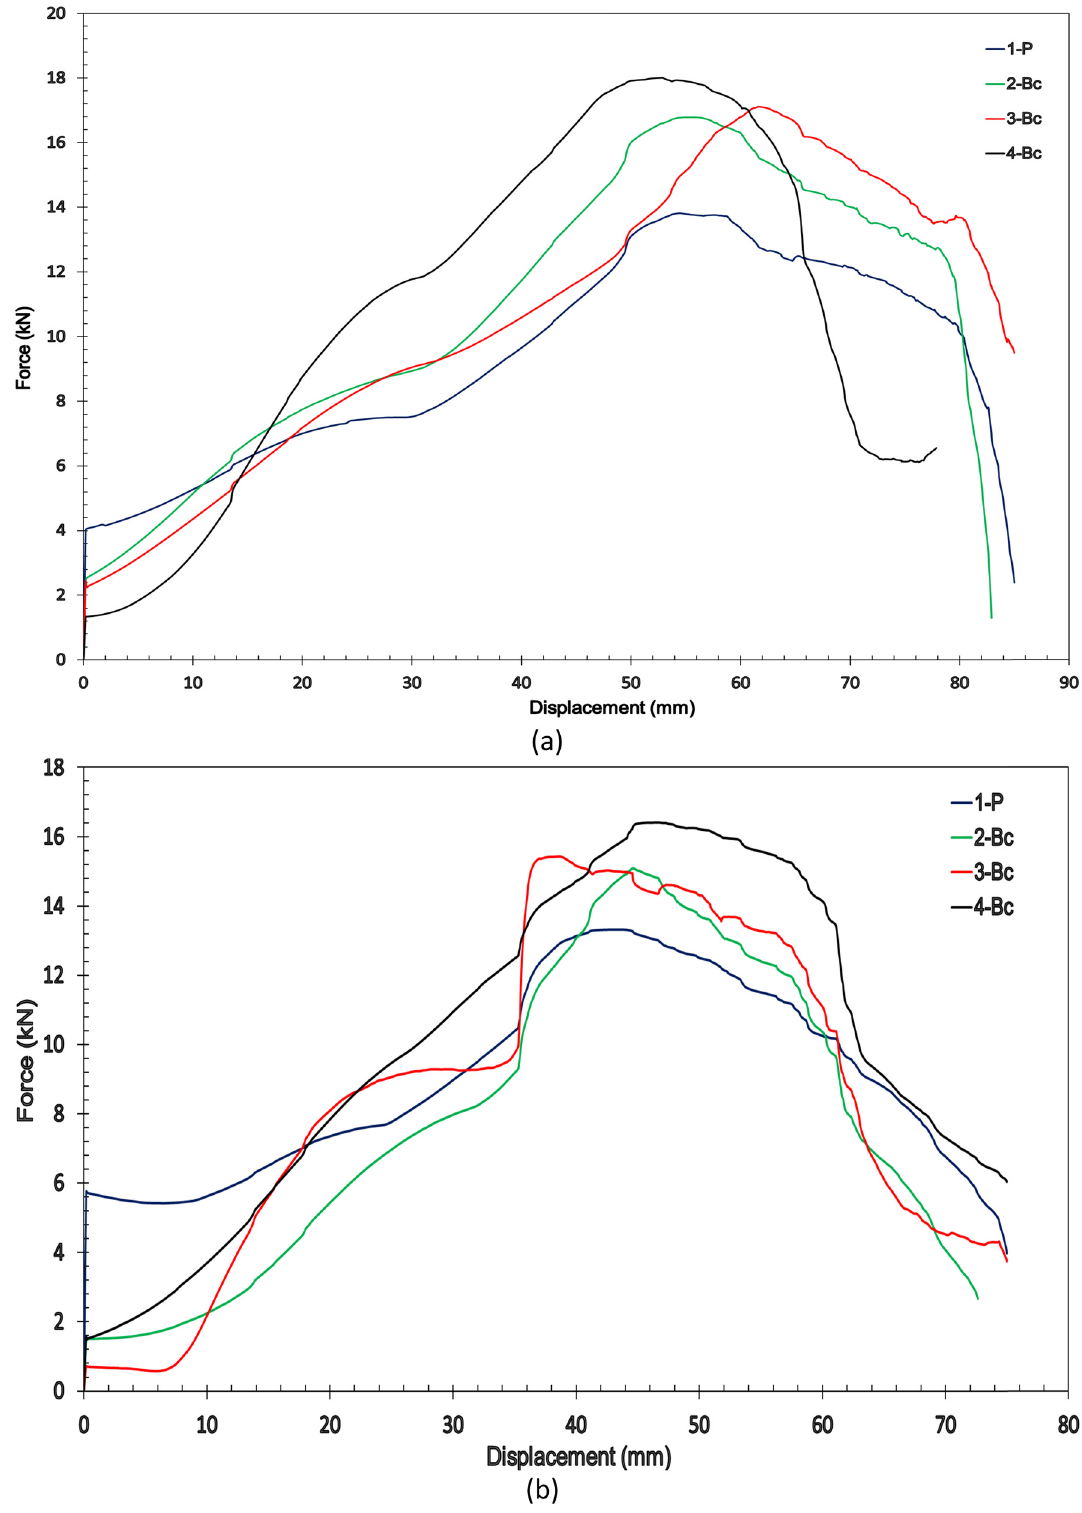
Figure 7: Force vs displacement of the Cu billets processed through ( a ) 90° - die and ( b ) 120° -